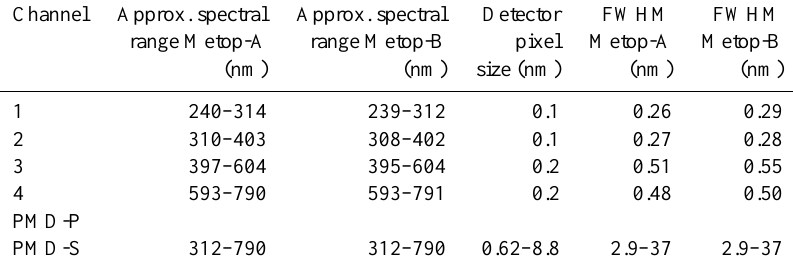
Table 2. GOME-2 spectral coverage and